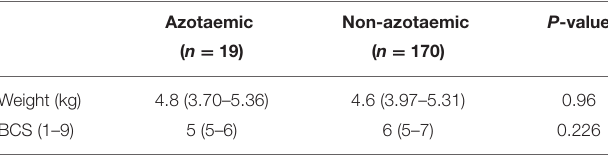
TABLE 3 | Relationship between weight, BCS, and azotaemia in 189 cats at